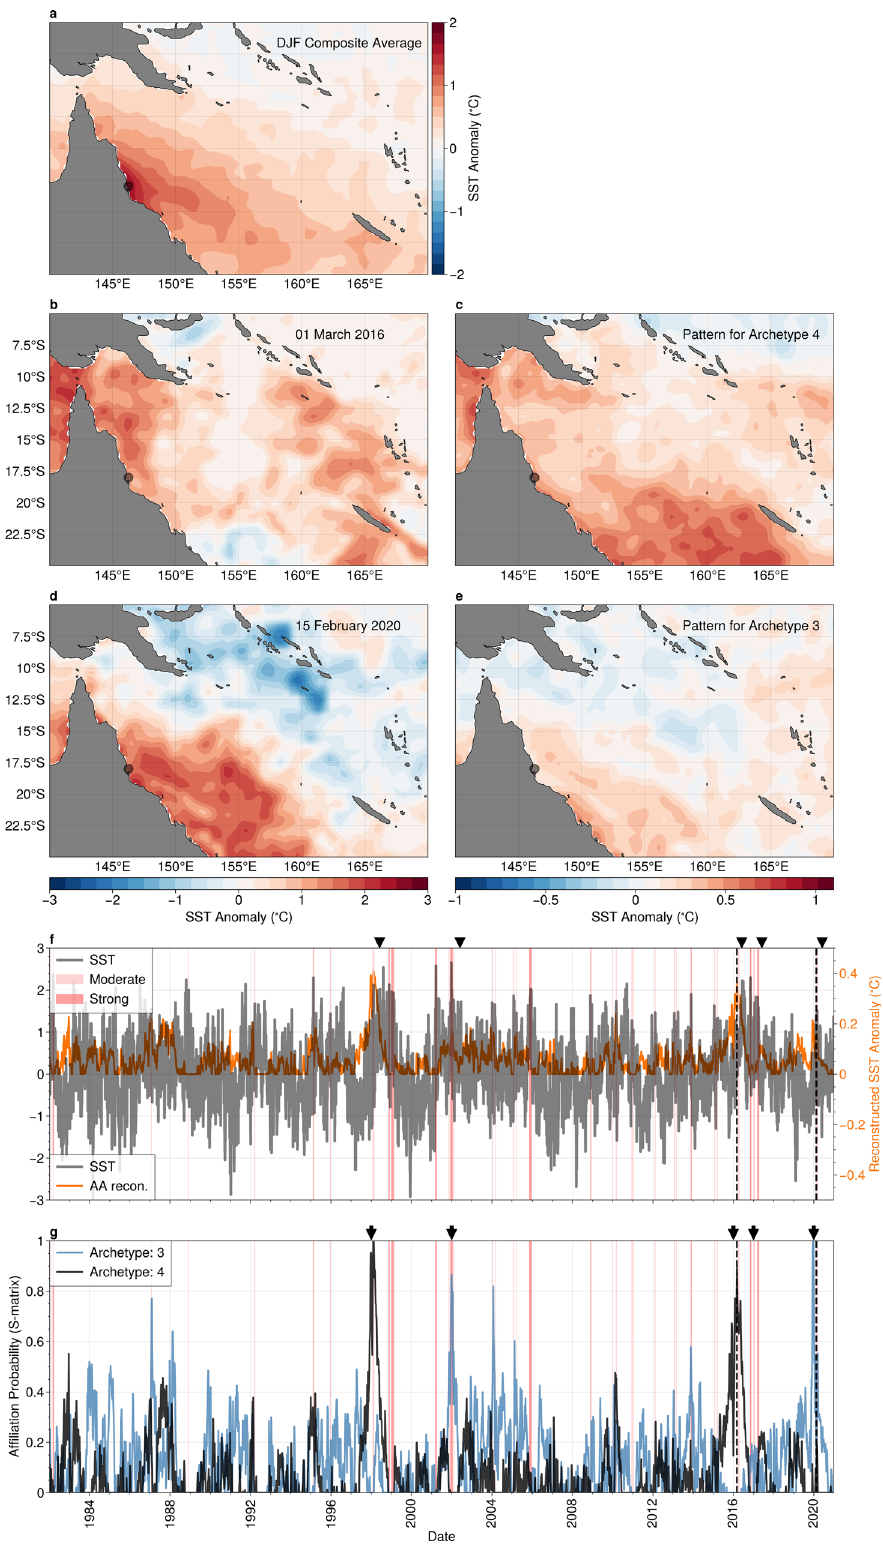
Fig.7|TherelationshipbetweenMarineHeatWavesandArchetypes#3and#4 in the Great Barrier Reef region. a Composite average of the sea-surface tem- perature(SST)anomalyforallsummertimemearineheatwavesatarepresentative location (18°S, 146.25°E), indicated by the grey circle; c , d daily SST anomaly snapshot for the peak of 2016 marine heatwave; c the SST anomalies for best matchingarchetypalpatternforthe2016event(archetype#4); d , e asin c , d forthe